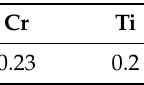
Table 2. Nominal chemical compositions of AA7075-T6 (wt.%).